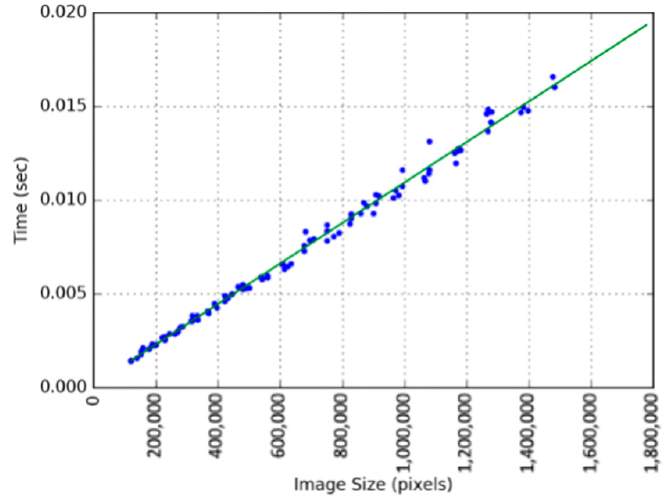
Figure 4. Estimated encryption time of AES 256.